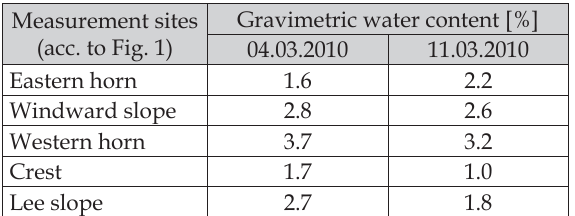
Table 2. The gravimetric water content of the subsur-